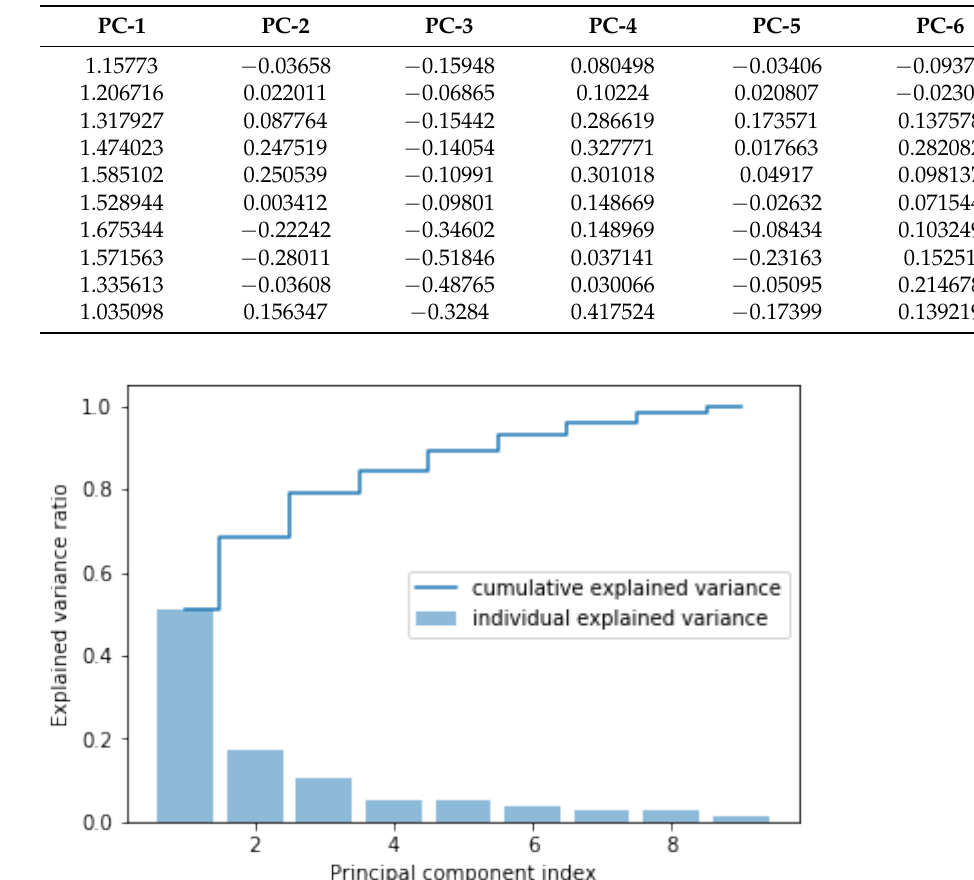
Table 7. Pricipal components for first 10 load data samples used for HAM.